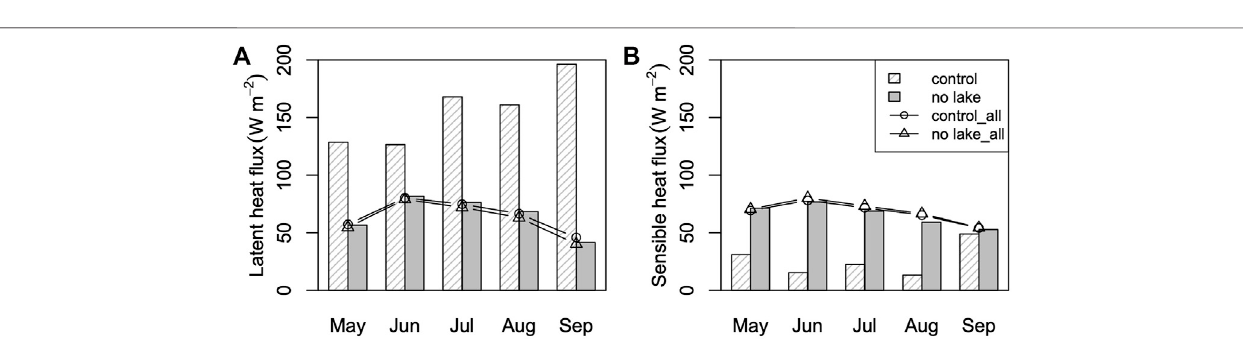
Frontiers in Earth Science |